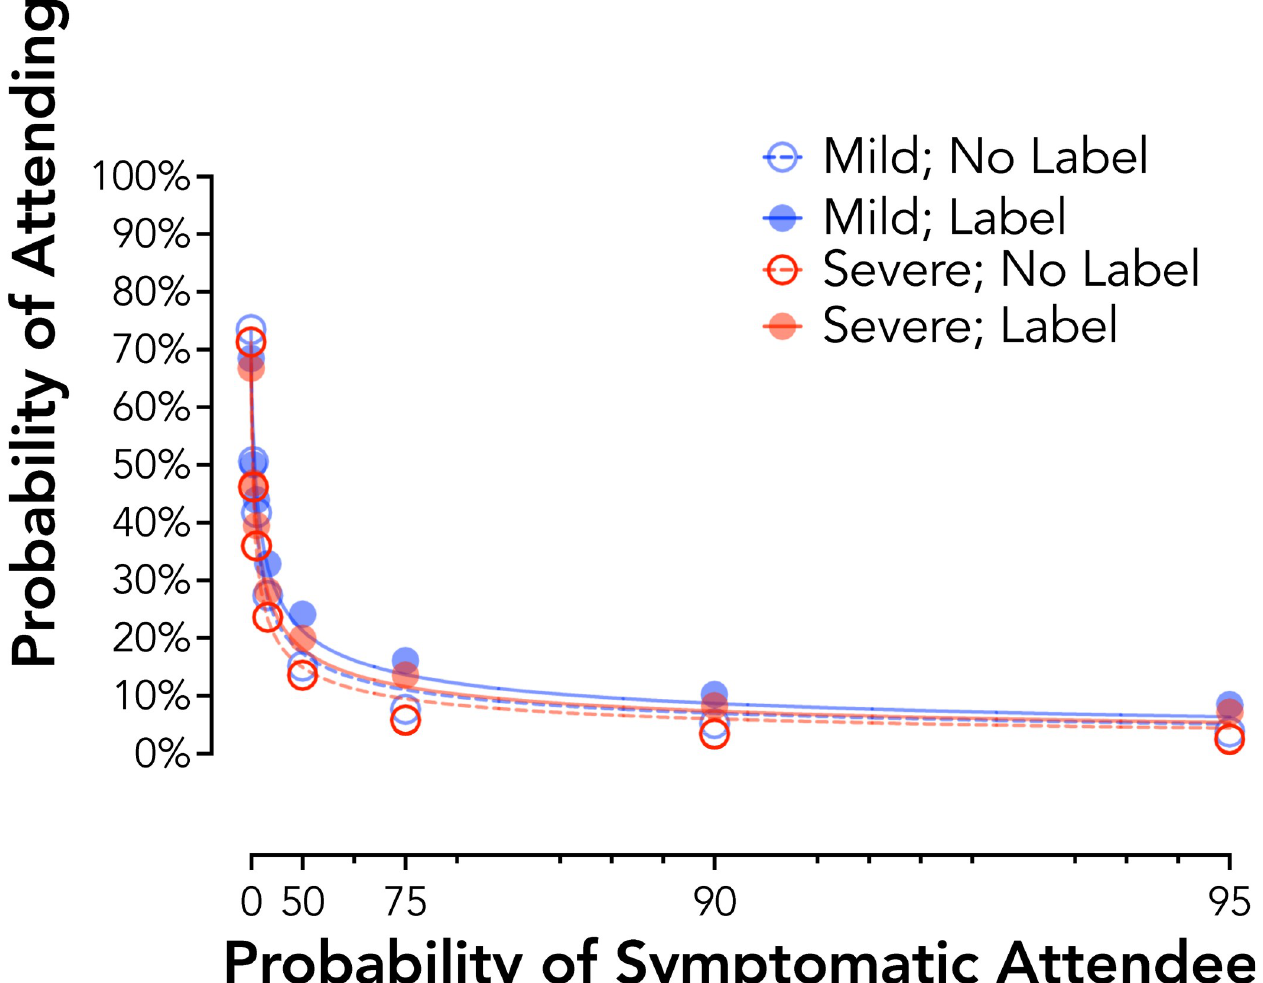
Fig 1. Probability discounting of social event attendance by symptom framing (Experiment 1). Plotted are group discounting curves by severity (mild = blue circles; severe = red circles) and label type (no label = open circles, dotted line; label = closed circles, solid line). X axis values are analyzed as odds in favor of a symptomatic attendee. Curves are plotted using the hyperbolic discounting equation including a non-linear scaling parameter